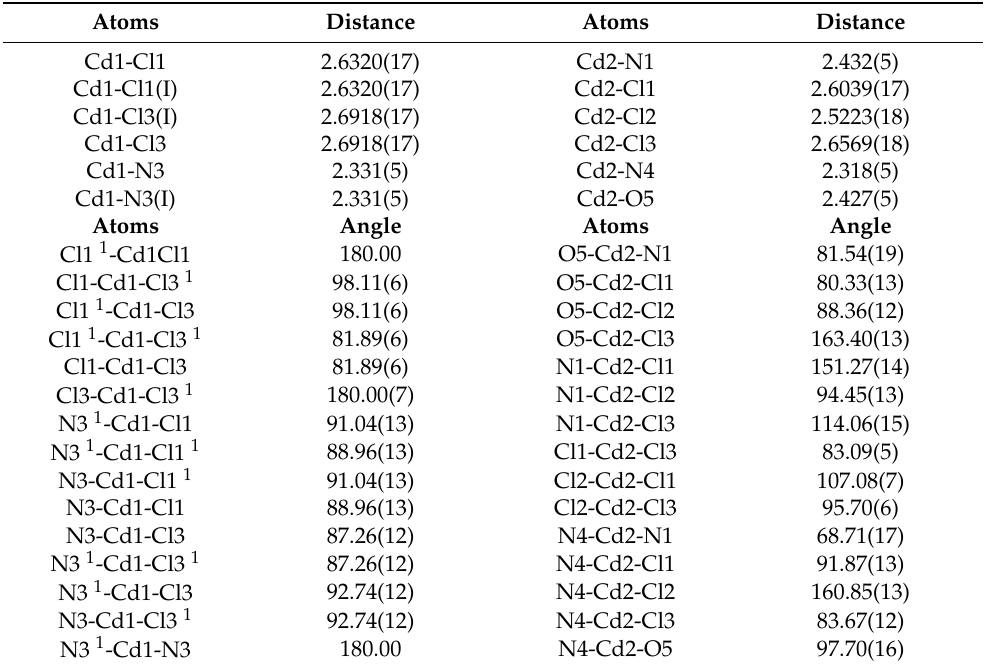
Table 6. Bond distances (Å) and angles ( ◦ ) for 3 .